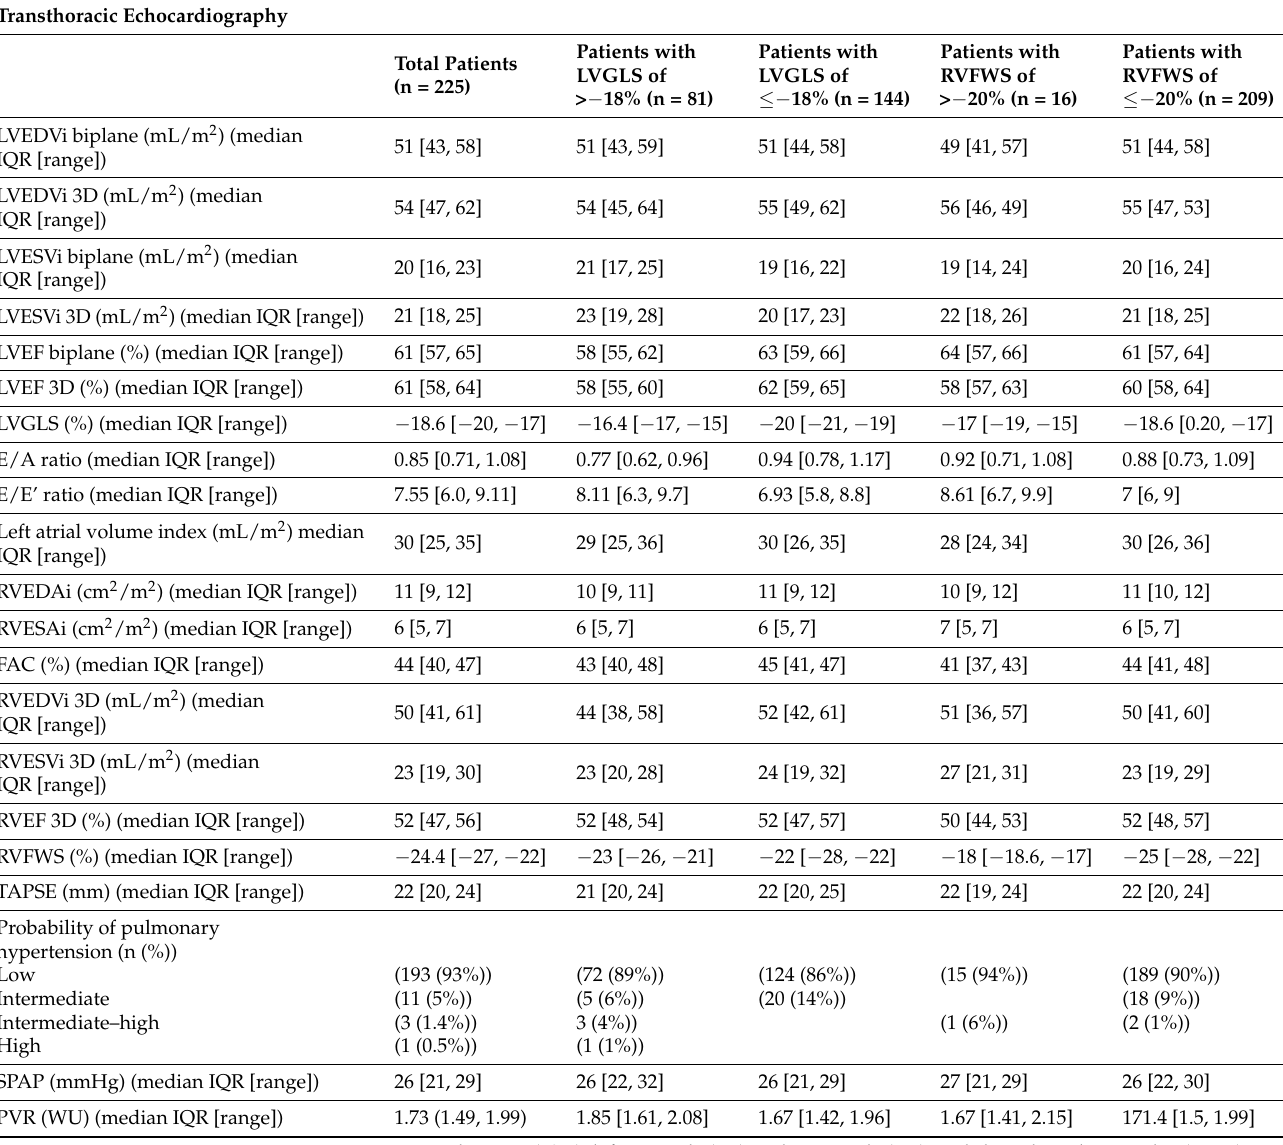
Table 3. Characteristics at the first follow-up visits (echocardiogram parameters) with differences between the patients with and without subclinical